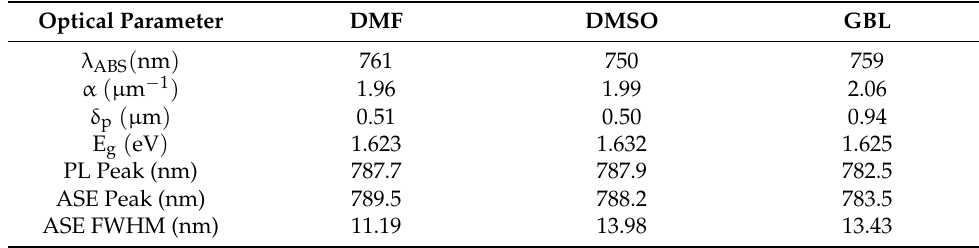
Table 3. Optical constants of the MAPbI 3 thin films prepared using different solvents. Optical Parameter DMF DMSO